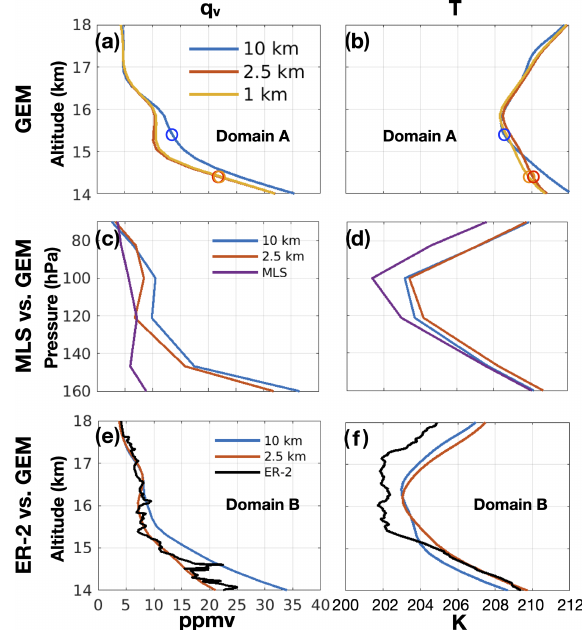
Figure 6. (a, b) The mean profiles of water vapour volume mix- ing ratio ( q v ) and temperature ( T ) for Domain A during the 5h period. The circles indicate the positions of the tropopause (mean (cid:48) < 2 ◦ Ckm − 1 ). (c, d) Mean profiles ( q v and T ) after applying av- eraging kernels of MLS to the GEM 2.5km and 10km simulations (100km × 100km areas centred on five MLS footprints) and MLS profiles. (e, f) The vertical profiles ( q v and T ) within Domain B for GEM 10km and 2.5km simulations and for ER-2 aircraft in situ